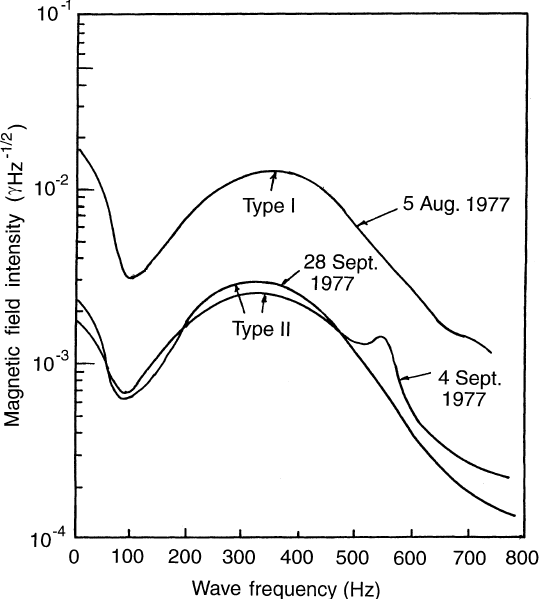
Fig. 1. Magnetic field intensity versus frequency curves of plasma- spheric ELF hiss emissions as observed by GEOS-1 satellite (after Hayakawa et al ., 1987)